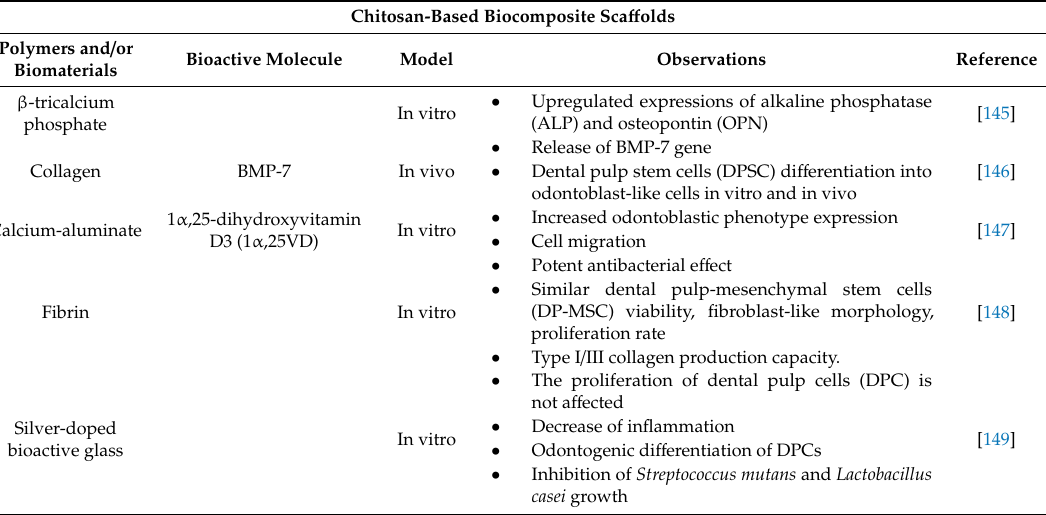
Table 2. Chitosan-based sca ff old in dental-pulp